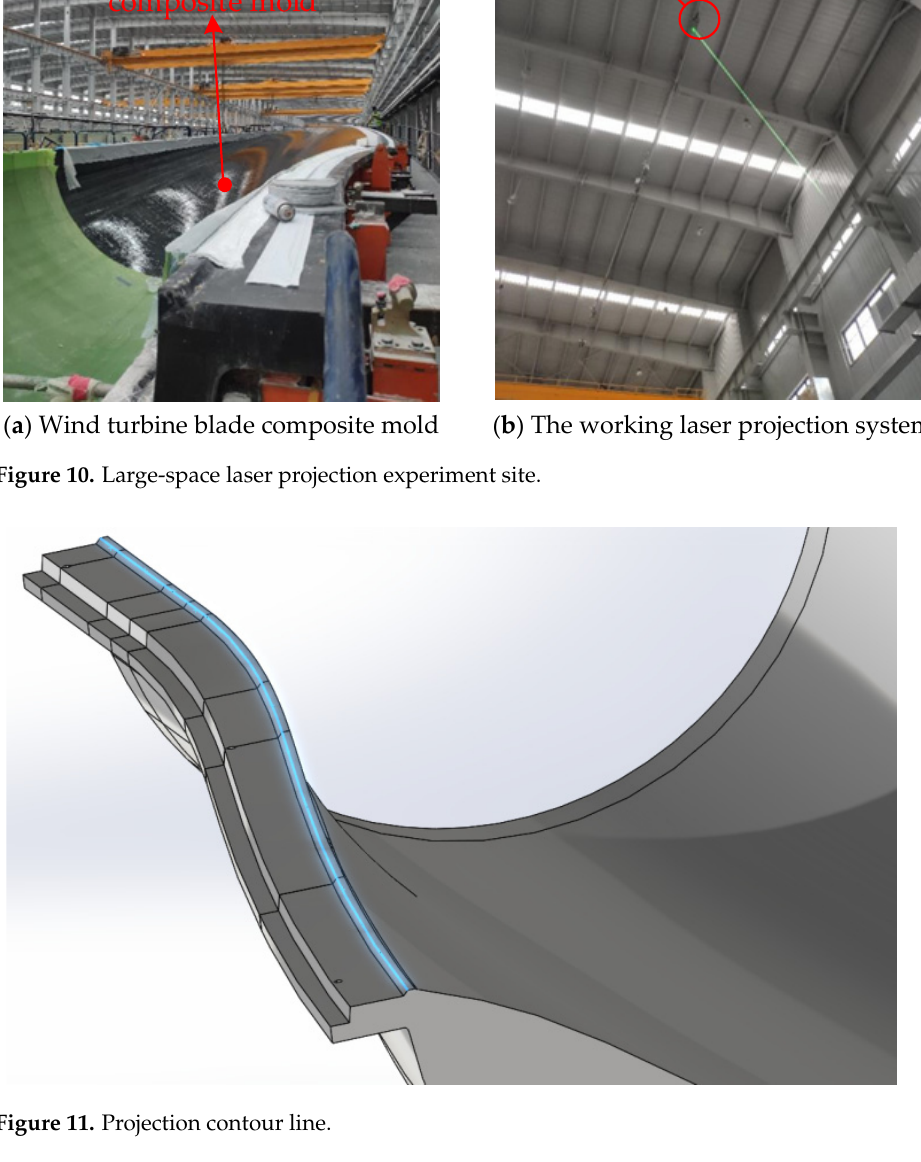
Figure 11. Projection contour line.